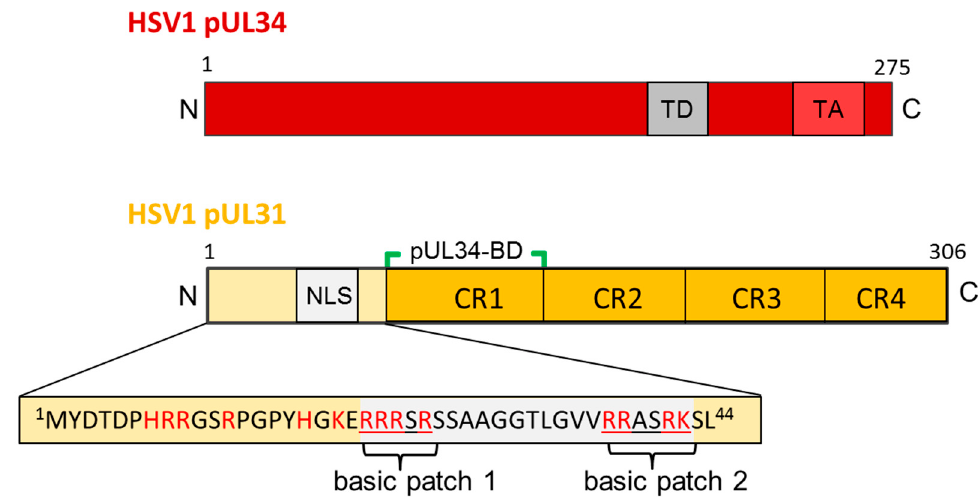
Figure 3. The HSV1 nuclear egress proteins pUL34 and pUL31. Graphical depiction of HSV1 pUL34 and pUL31 and their domain organisation. The amino acid sequence of the N-terminal domain of pUL31 is detailed. N: N-terminus; C: C-terminus; TD: targeting domain; TA: Tail-anchor domain; NLS: nuclear localization sequence; pUL34-BD: pUL34-binding domain; CR: conserved region. Most recently, the NEC of three different herpesviruses, Herpes simplex virus 1 (HSV1; Figure 4; [38]), Pseudorabies Virus (PrV; [38,39]) and Human Cytomegalovirus (HCMV; [40,41]) has been crystallized. All structures are remarkably similar consistent with nuclear egress being conserved throughout the herpesvirus family.